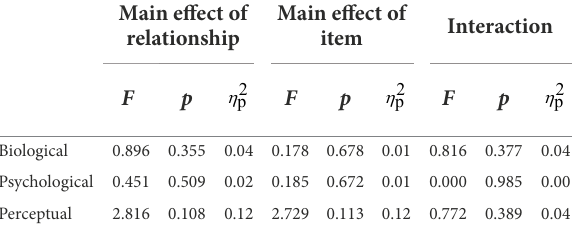
TABLE 8 Comparisons between children with hierarchical and egalitarian IC relationships in agency attributions to ball and